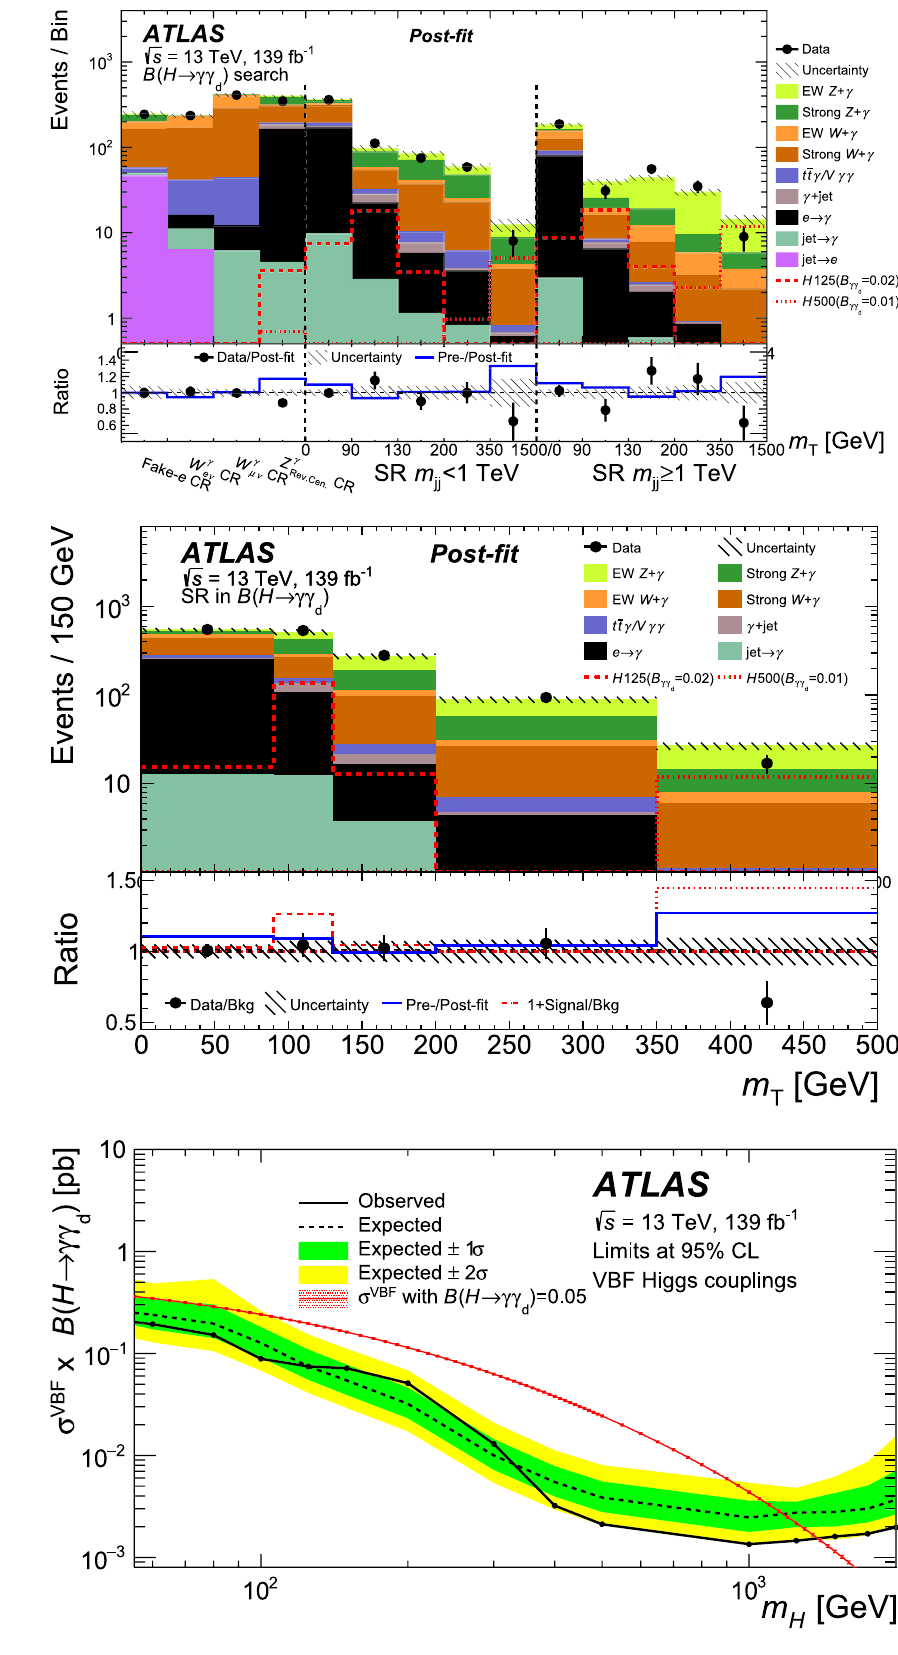
Fig. 7 The 95% CL upper limit on the Higgs boson production cross-section times branching ratio to γγ d for different VBF-produced scalar-mediator-mass hypotheses in the NWA. The theoretically predicted cross-section of a Higgs boson produced via VBF and with the B ( H → γγ ) = 5% is d superimposed on the ± 1 σ and ± 2 σ NNLO QCD + NLO EW uncertainty bands of the expected production cross-section